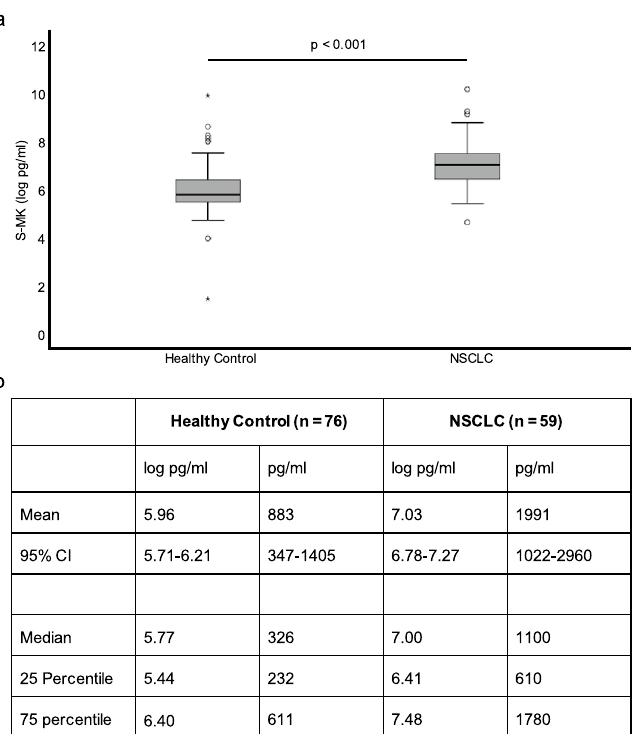
Figure 2. S-MK expression is upregulated in patients with NSCLC compared to healthy controls. Abbreviations: S-MK serum-midkine, NSCLC non-small lung cancer, pg picogram, ml milliliter, CI confidence interval. ( a ) Data are shown in a box-and-whisker plot (median, 25th and 75th percentile, range, extreme values outside the range). ( b ) Data are expressed as means +/− 95% CI and medians +/− interquartile ranges. Statistical significance was determined using an unpaired t-test, p <